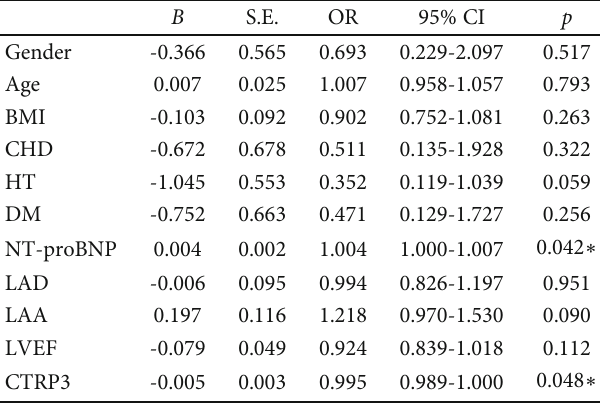
Table 4: Logistic regression analysis for the presence of AF.